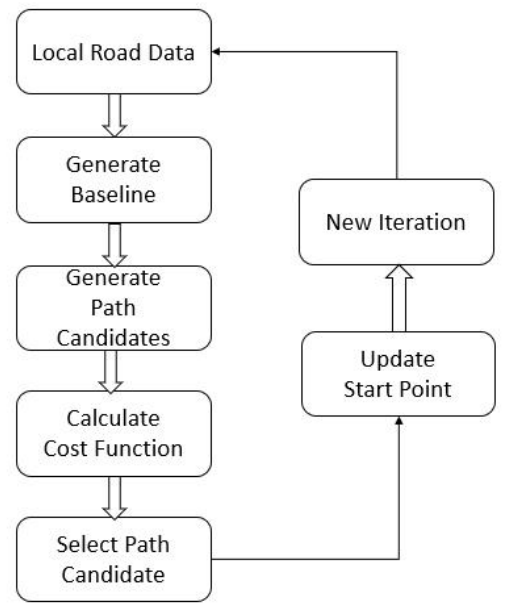
Figure 3. Algorithm flowchart for path